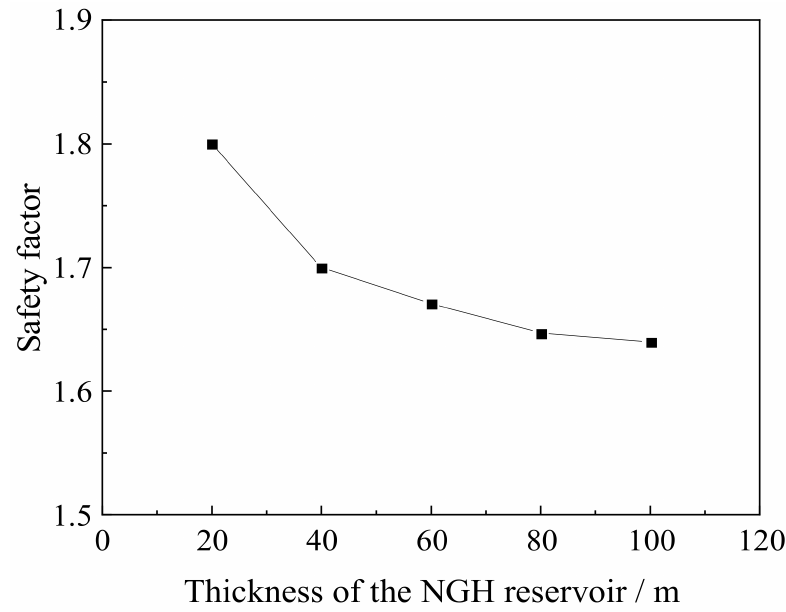
Figure 10. Safety factors corresponding to different reservoir